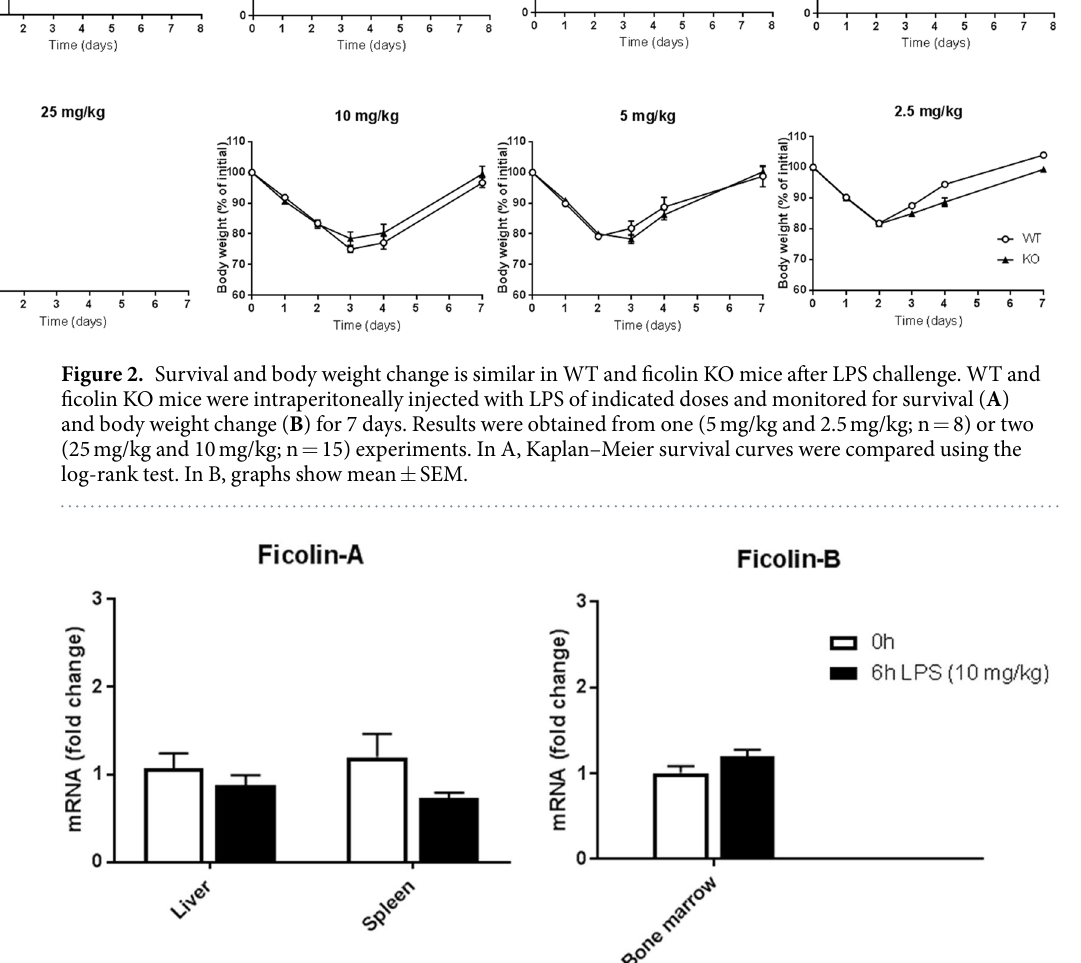
Figure 3. Ficolin expression is unaltered in mice after LPS challenge. Groups of WT mice were untreated or intraperitoneally injected with LPS of a lethal dose (10 mg/kg) and sacrificed after 6 h. Liver, spleen and bone marrow were removed and expression of ficolin-A and ficolin-B in tissue homogenates was measured by qPCR. Data was obtained from one experiment and represent mean ± SEM (n = 5) as the fold change from naive WT